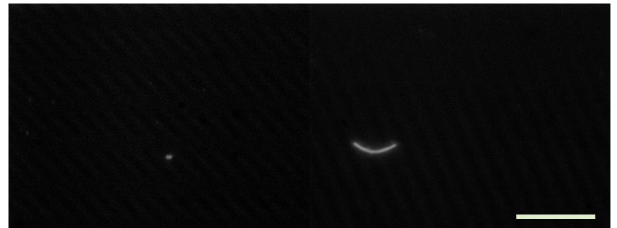
Figure 2. G-DW biofilm sample obtained in winter season with FISH positive E. coli (left) and DVC-FISH positive E. coli (right) Bar 10 µ